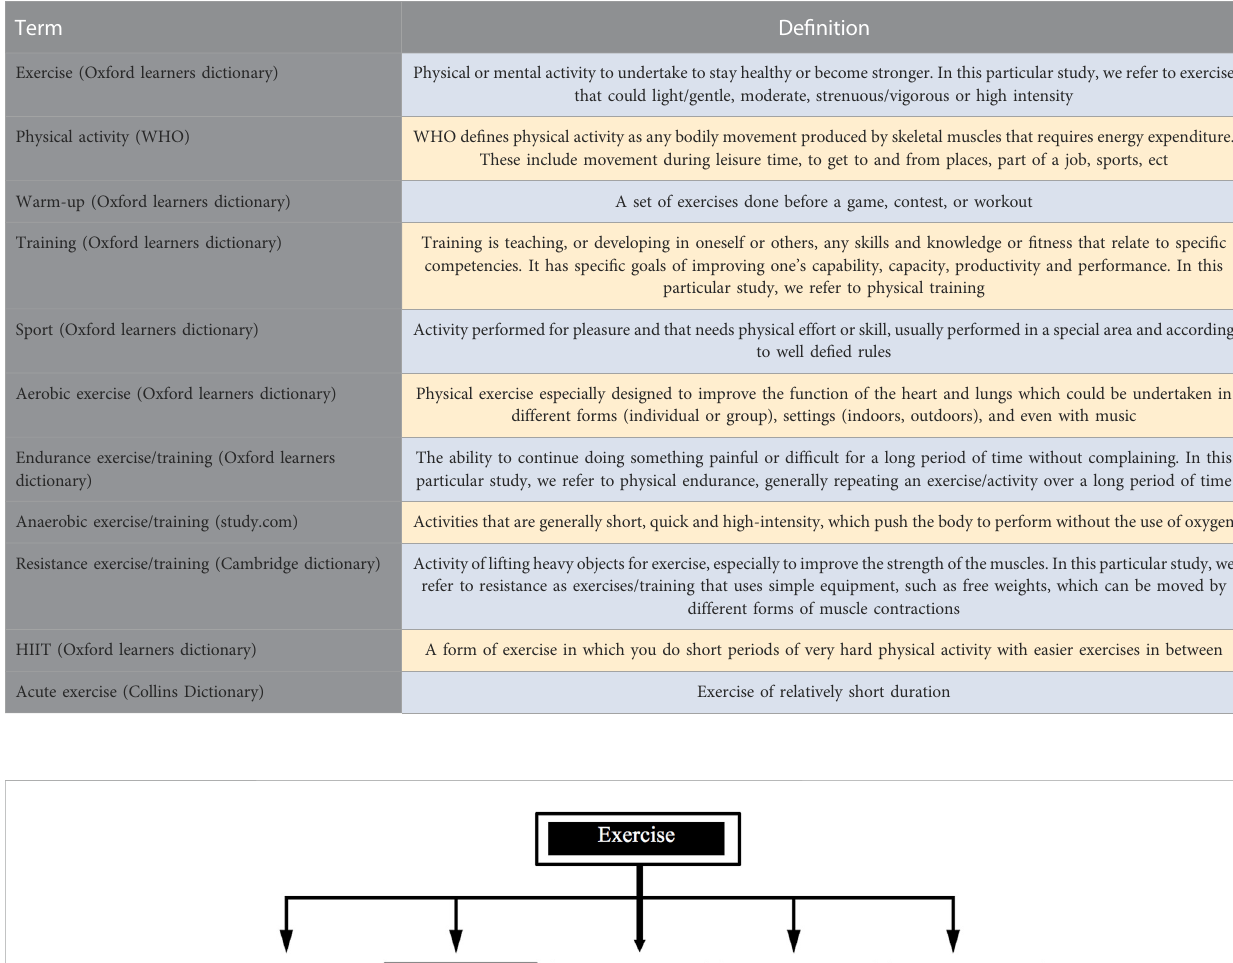
TABLE 1 Speci fi c terms ’ de fi nitions.